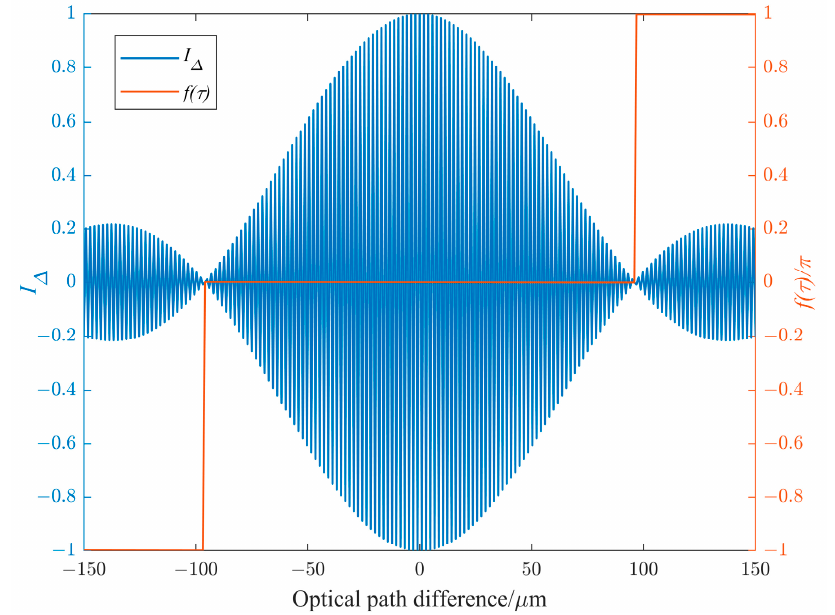
I Figure 2. Simulated interference term I ∆ and phase f ( τ ) associated with the spectral shape for a τ Figure 2. Simulated interference term associated with the spectral shape Δ and phase ( ) f range of optical path difference [ − 150 µ m, 150 µ m]. for a range of optical path di ff erence [ − 150 µm, 150 µm]. For the same target, under the same experimental conditions of frequency response, dispersion, detector response, etc., the interference terms measured from different baselines have the same envelope shape. The difference is that the extrema will be enlarged or reduced by the same proportion when the modulus of the complex coherence factor is different; the extrema will be different when the phase of the complex coherence factor is different. Therefore, the phase difference between the interferometric signals corresponding to different baselines can be determined from the Rmax m or Rmin m of the normalized n n interference terms in the region of approximately linear variation of the envelope shape. Citing the simulation results of the influence of phase measurement error on reconstruction image quality in reference [36], when the mean value of the phase measurement error is 0, the standard deviation of the phase measurement error must be less than 0.18 π to ensure the high quality of the reconstructed image. Therefore, the phase measurement accuracy of the proposed method is sufficient to ensure a high enough reconstruction image quality to meet the application